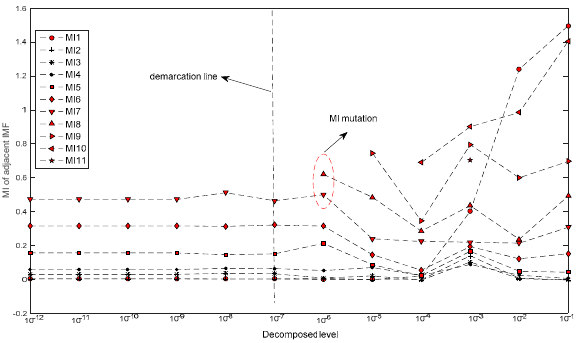
Figure 12. Decomposition result for simulated vibration signal (SVS) signal under different decomposing level.